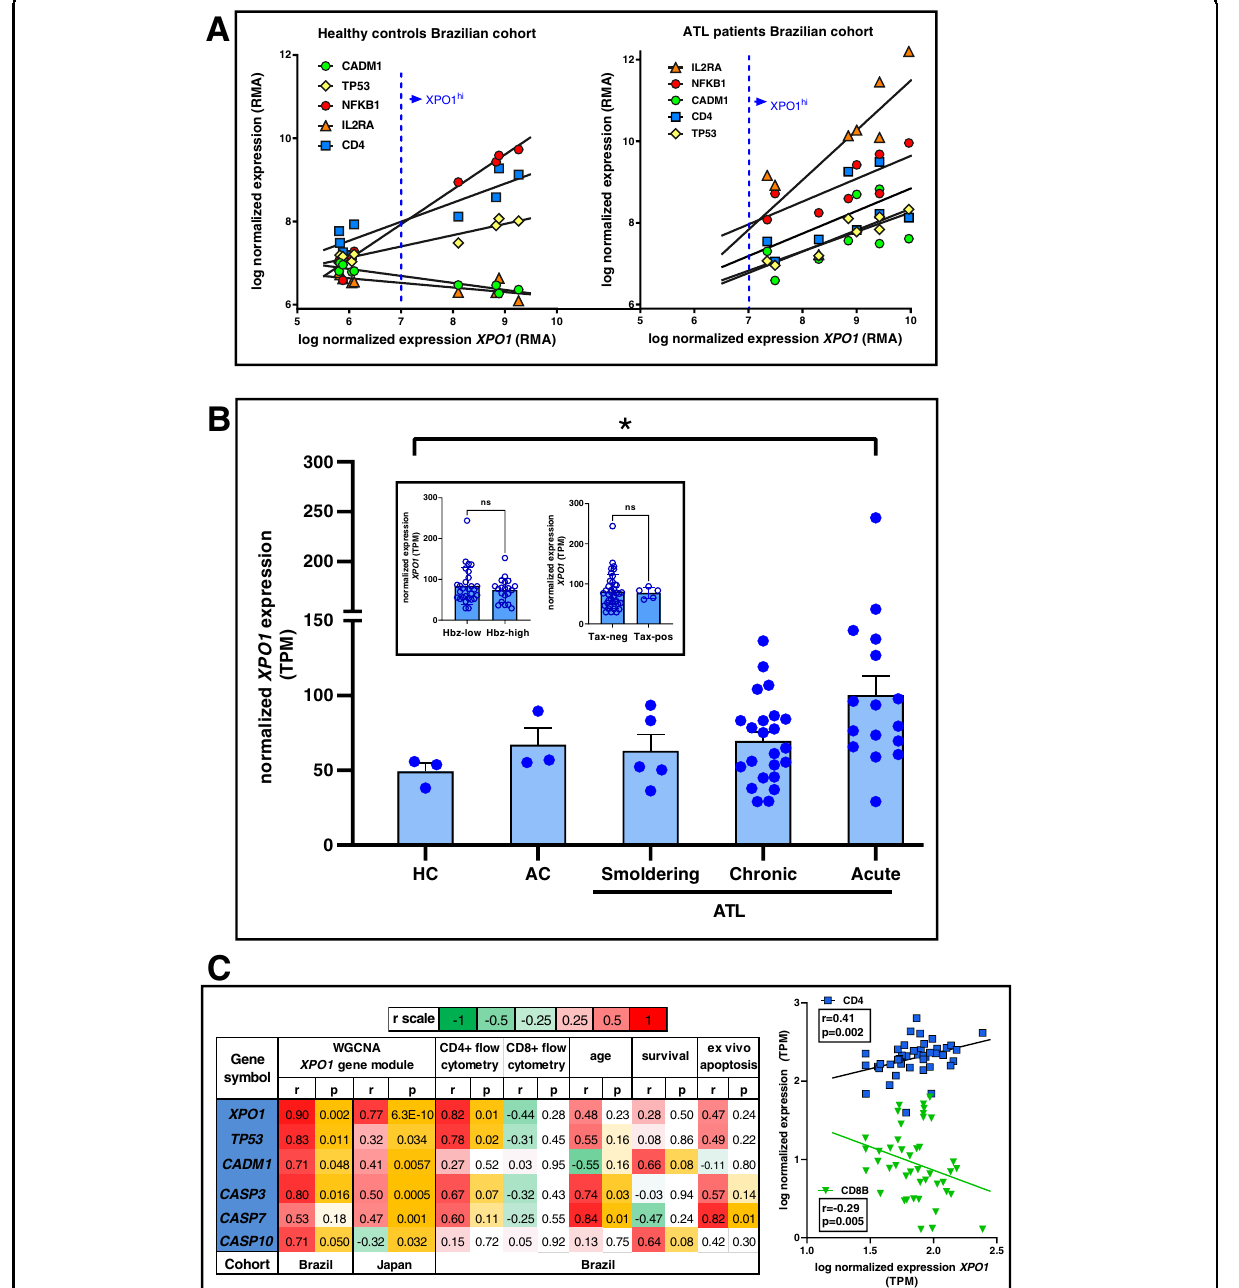
Fig. 1 XPO1 transcripts positively correlate to leukemic markers CD4/IL2RA/CADM1, TP53/NKFB1 transcripts and clinical progression in Adult T-cell Leukemia patients. A XPO1 transcripts were analyzed by transcriptome-wide correlation in PBMC from healthy controls and Adult T-cell leukemia patients from the Brazilian cohort. Data are expressed as RMA (Robust Multi-array Average). Spearman correlation was used (all p < 0.05). B XPO1 levels increase with clinical progression to aggressive ATL. XPO1 transcript levels were quanti fi ed in matched samples from the Japanese cohort: healthy controls (HC), asymptomatic carriers (AC), and patients with smoldering, chronic and acute ATL (* p < 0.05 ANOVA with post-test for linear trend). Inset: XPO1 expression does not differ between Hbz-high expressing (>10 transcripts per million, TPM) or Hbz-low expressing (<10 TPM) ATL patients, or between Tax-positive and Tax-negative ATL patient samples ( p > 0.7 for both). C Whole Genome Correlation Network Analysis (WGCNA) demonstrates XPO1 belongs to the same transcriptional module as leukemic marker CADM1 , apoptosis regulators TP53 and caspases ( CASP3-7-10 ). Spearman test was used for correlation with WGCNA gene module ‘ eigengene ’ (con fi rming the similarity in the XPO1 gene module in both Brazilian and Japanese cohorts) and patient data (age, survival, fl ow cytometry, ex vivo apoptosis measured after short-term culture of primary cells) for the Brazilian cohort (left panel) and CD4 and CD8B transcripts for the Japanese cohort (right